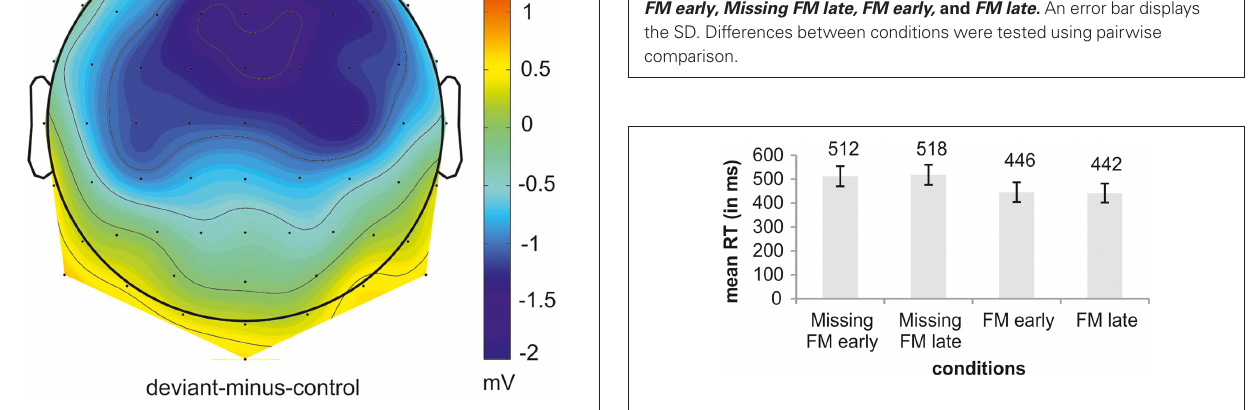
Figure 4 | illustration of mean rTs (in ms) for the conditions Missing FM early , Missing FM late, FM early, and FM late . An error bar displays the SD. Differences between conditions were tested using